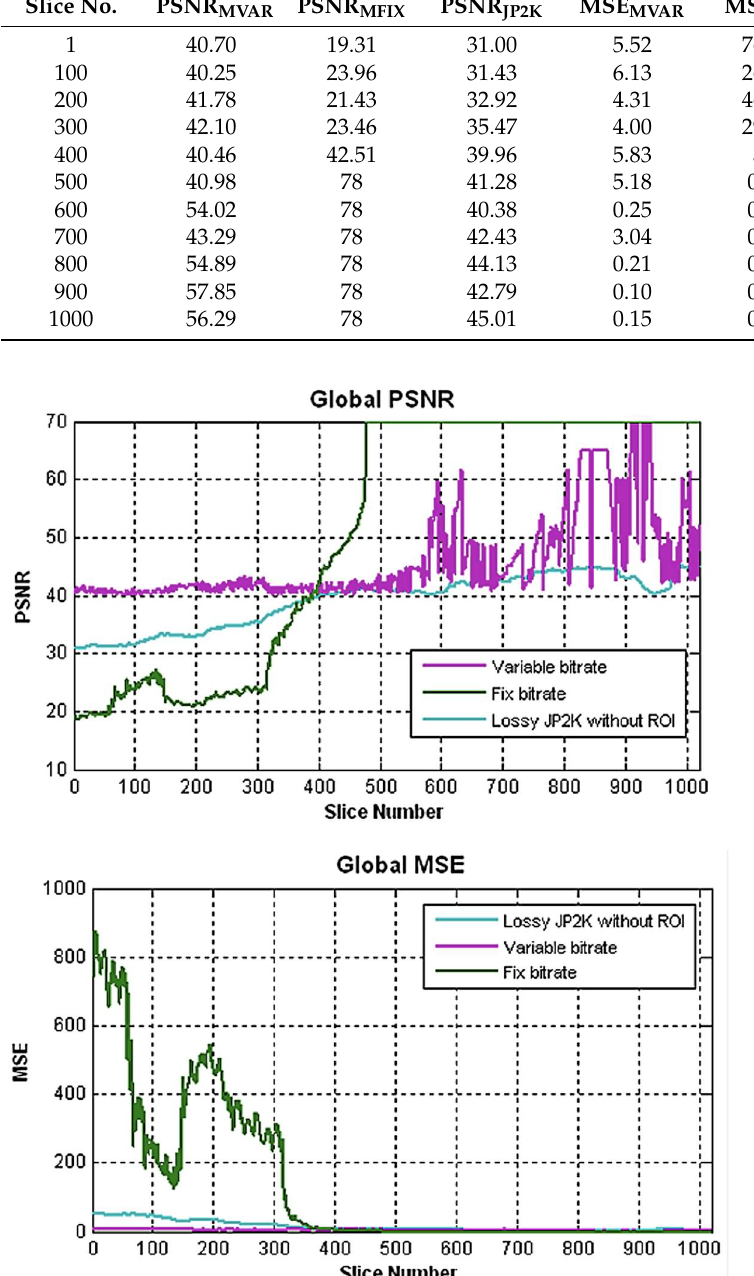
Figure 4. Comparison of the peak signal-to-noise ratios (PSNR) and mean-squared errors (MSE) between the three different evaluated compression methods for a single 1000-slice CTA from the sample dataset.